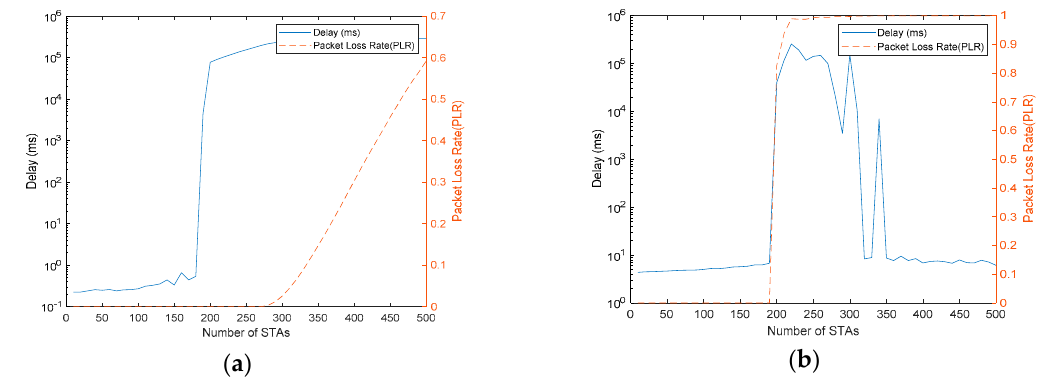
Figure 12. Average delay and PLR in two bands transmission case: ( a ) Conventional IEEE 802.11p channel access scenario; ( b ) Proposed V2X-UORA channel access scenario.